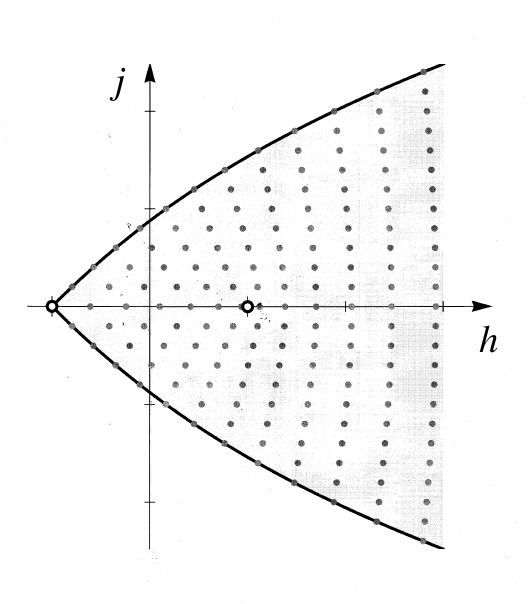
Figure 1. The Bohr–Sommerfeld quantum states of the spherical pendulum in R